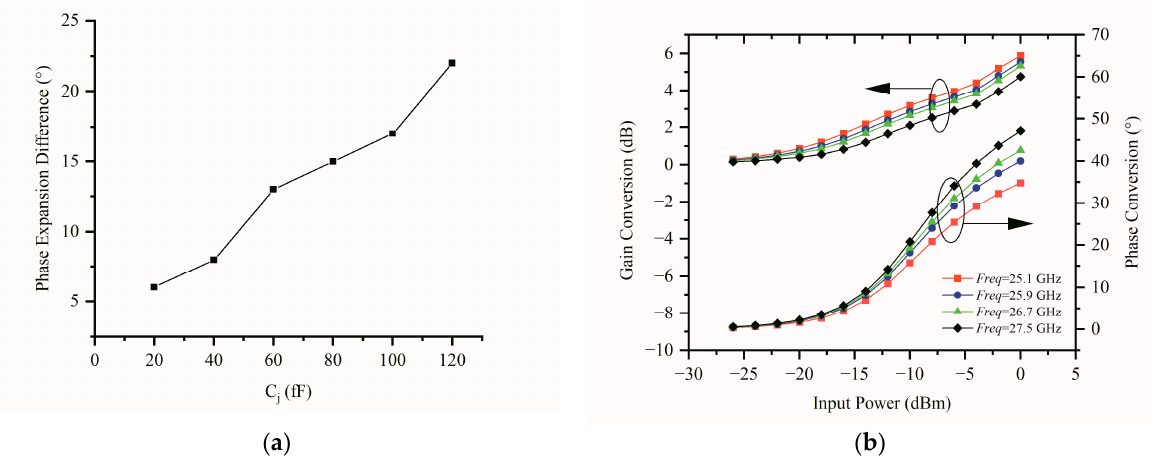
Figure 6. ( a ) Phase expansion di ff erence with Cj. ( b ) Gain and phase expansion after adding NFAM to APD